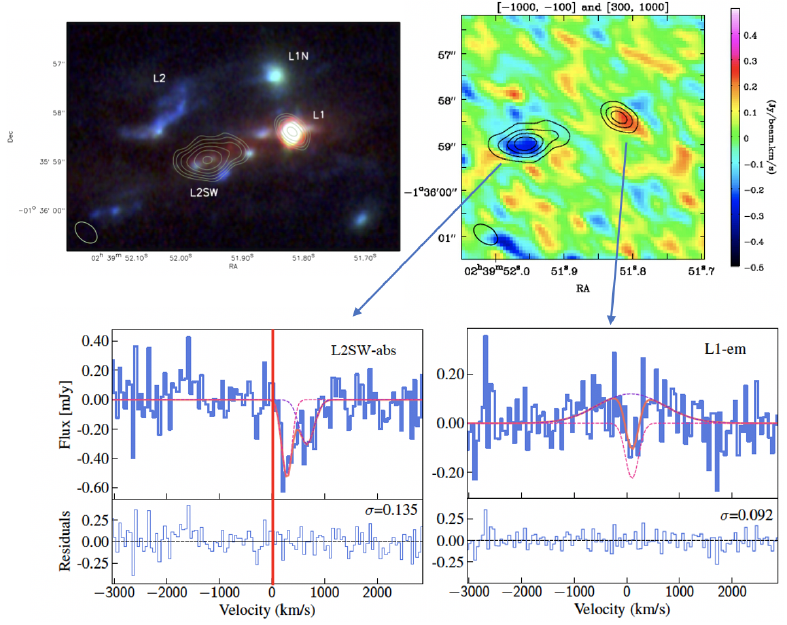
Figure 1: Upper row: Left: ALMA rest-frame 360- µ m continuum image of SMM J02399 0136 over a false-colour composite from Frontier Fields HST frames. Right: − Map of the CH + line integrated area (i.e. moment-0) over the velocity range [-1000,-100] and [300,1000] km s − 1 . Lower row: Two CH + (1-0) continuum-subtracted ALMA spectra, the residuals and the r.m.s noise level are also shown. The dashed lines show individual Gaussian fits to the emission and absorption components. The spectra are obtained over the L2SW continuum peak ( left ), and over a solid angle of 1 arcsec 2 south-west of L1 ( right ). ⇠ We have observed and detected the J =1-0 transition of CH + in 18 starburst galaxies at z 2-3. One of the targets is SMM J02399 0136, a galaxy group lensed by the Abell 370 ' − 2